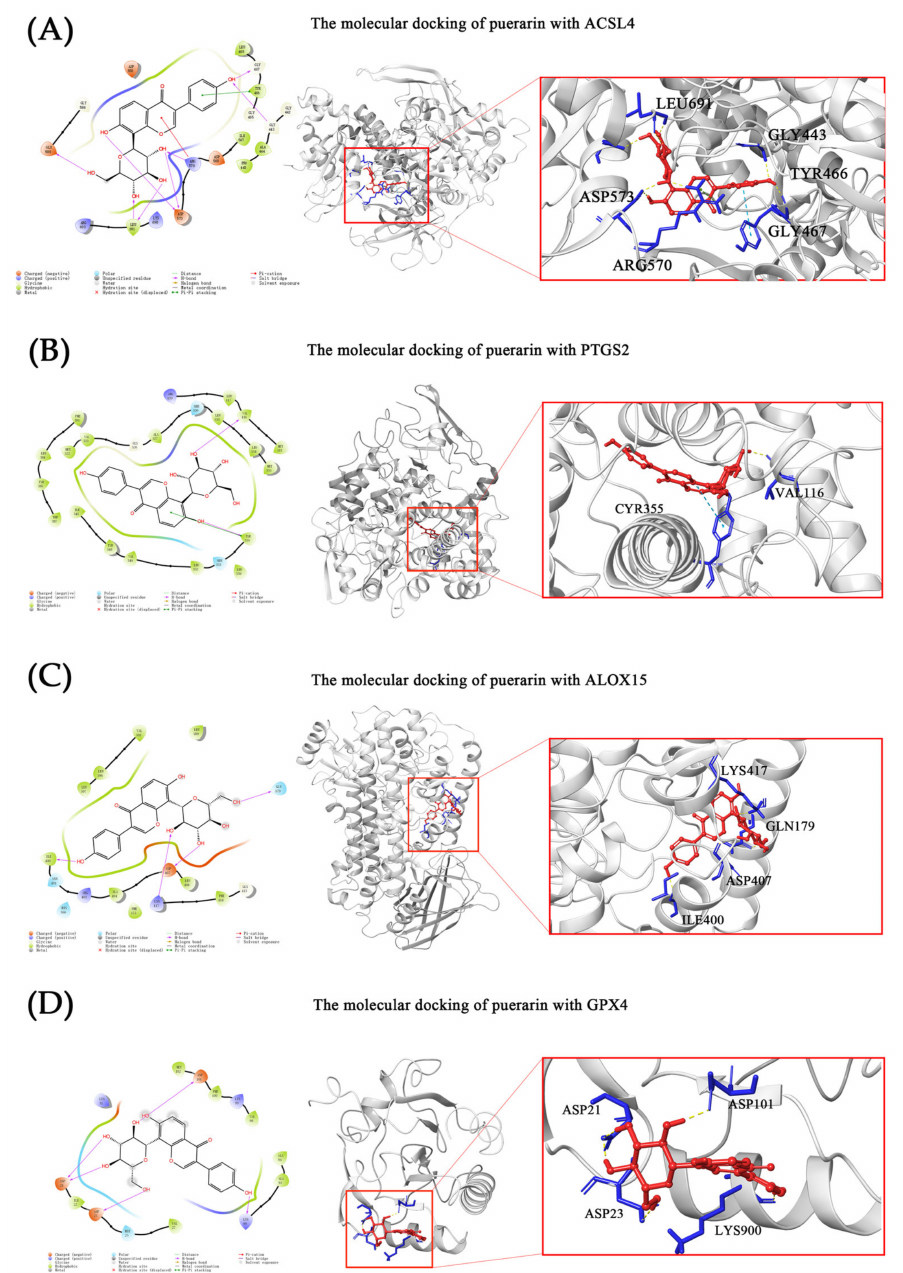
Figure 5. Predicted binding–interaction analysis and binding pose of ( A ) ACLS4, ( B ) PTGS2, ( C ) ALOX15 and ( D ) GPX4, with